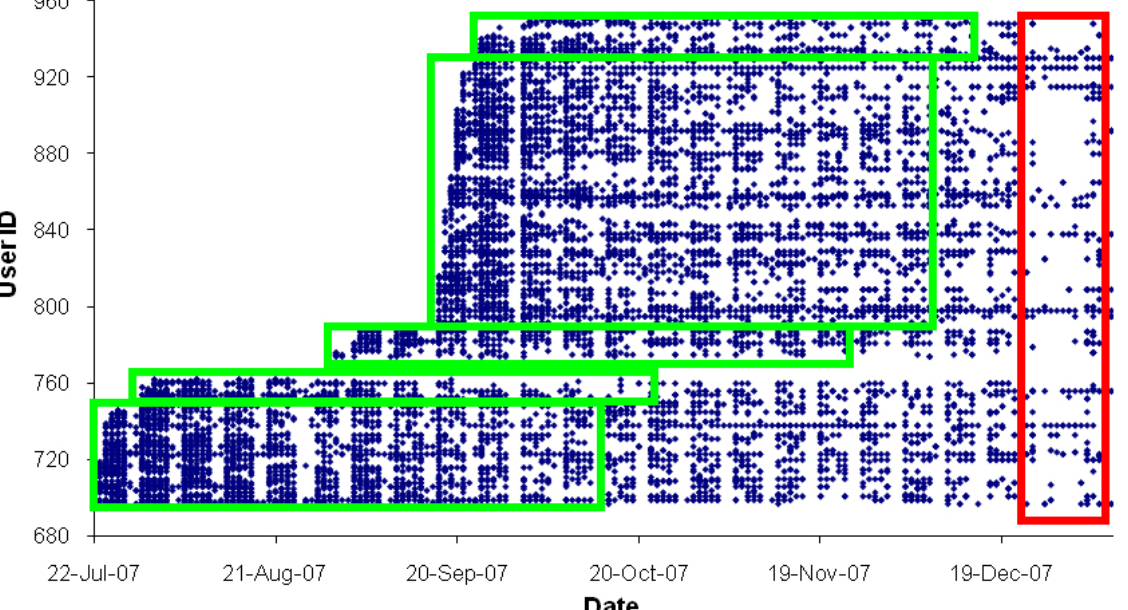
Figure 3. Participant’s log-in data throughout and following the study period (Each dot represents a user’s visit and log-in to the website. Green boxes are the website visits recorded during the 12-week study period. Data within the red box were recorded over the 2-week Christmas holiday period when the work sites were